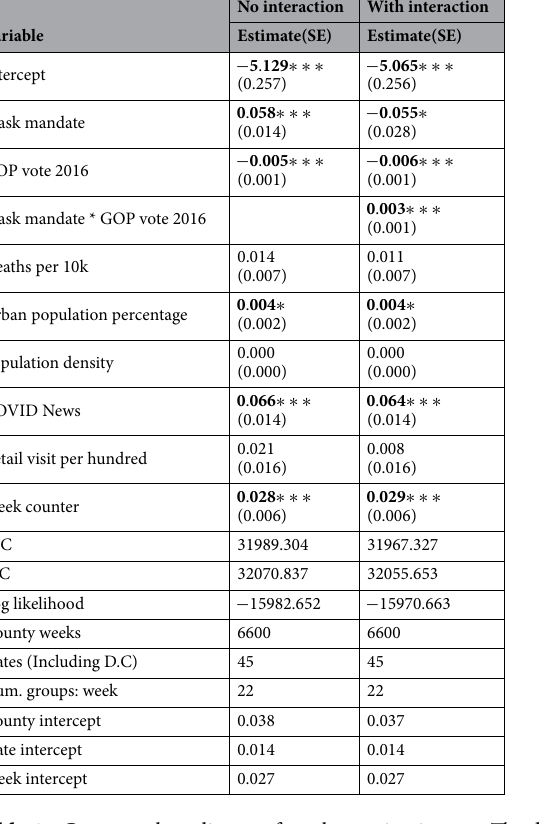
Table 4. Contextual predictors of mask-wearing images. The dependent variable is the proportion of Twitter users who posted mask-wearing images among users that posted any tweets with images. ∗ ∗ ∗ p < 0.001 ; ∗∗ p < 0.01 ; ∗ p <